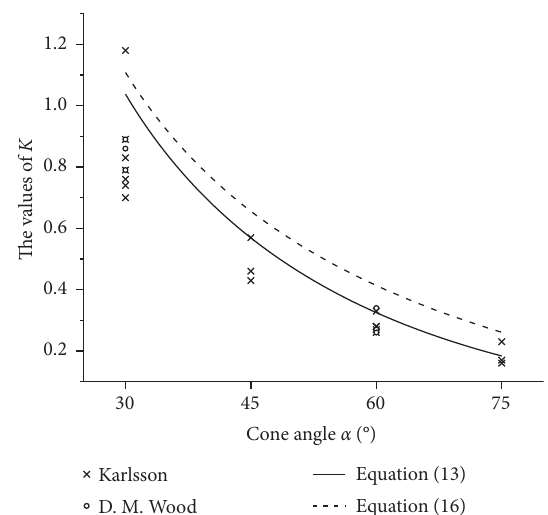
Figure 3: The function graph of K compared with experimental values of K